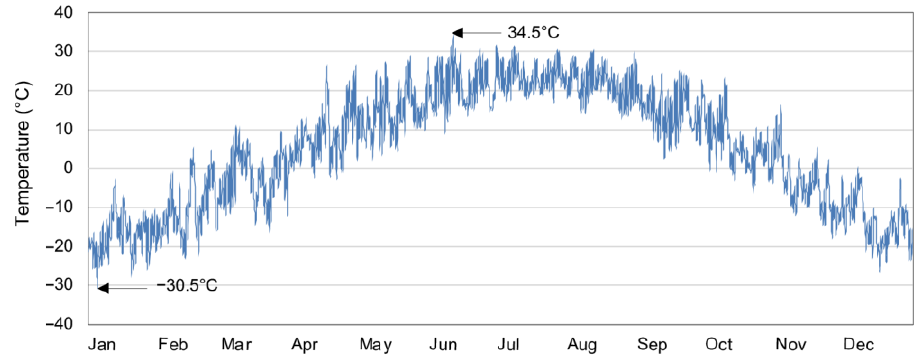
Figure 3. Outdoor temperature of Harbin from IWEC 2 weather file.